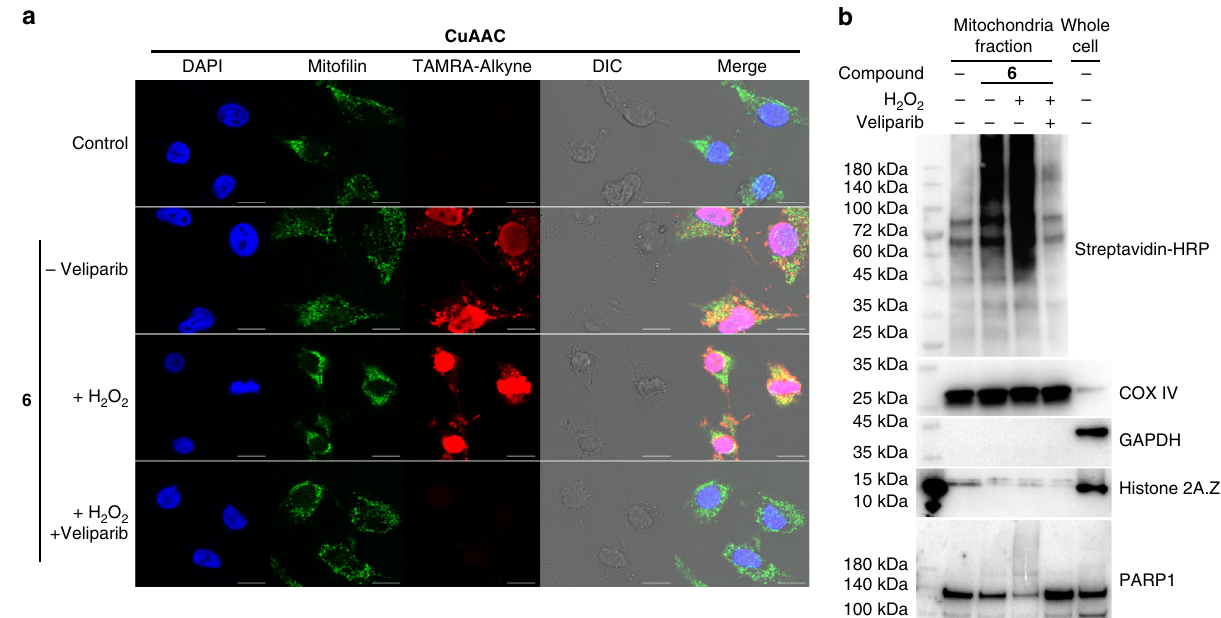
Fig. 8 Visualization and labeling of mitochondrial protein PARylation by 6 . HeLa cells were pretreated for 20 min in the absence and presence of H 2 O 2 and 1 µ M veliparib. Following permeabilization with 0.025% Triton-X-100, cells were incubated with 100 μ M 6 for 45 min, followed by a confocal microscopic analysis through fi xation, permeabilization, and fl uorescent staining by click chemistry, CuAAC: copper(I)-catalyzed azide alkyne cycloaddition, Alexa Fluor 488 conjugated anti-mito fi lin antibody, and DAPI. DIC: differential interference contrast. Scale bars: 10 μ m, and by b immunoblot analysis of mitochondria fraction as detected by a streptavidin-HRP conjugate following biotin conjugation via click chemistry. COX IV as mitochondrial protein loading controls were detected by an anti-COX IV antibody. GAPDH and Histone 2A.Z as cytosol and nuclear protein markers were detected by anti-GAPDH and anti- Histone 2A.Z antibodies, respectively. PARP1 was detected by an anti-PARP1 antibody. Source data are provided as a Source Data fi